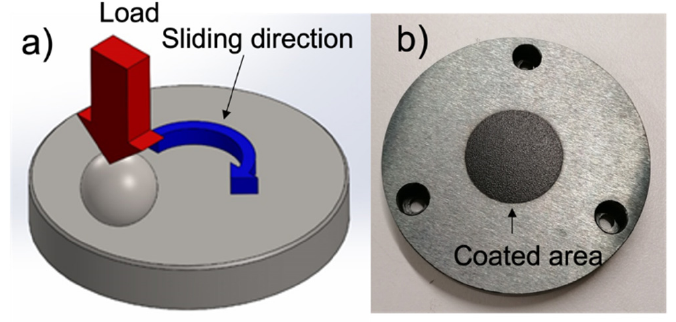
Figure 3. Schematic of tribological pin-on-disk contact ( a ) and a tribological specimen coated ( b ).